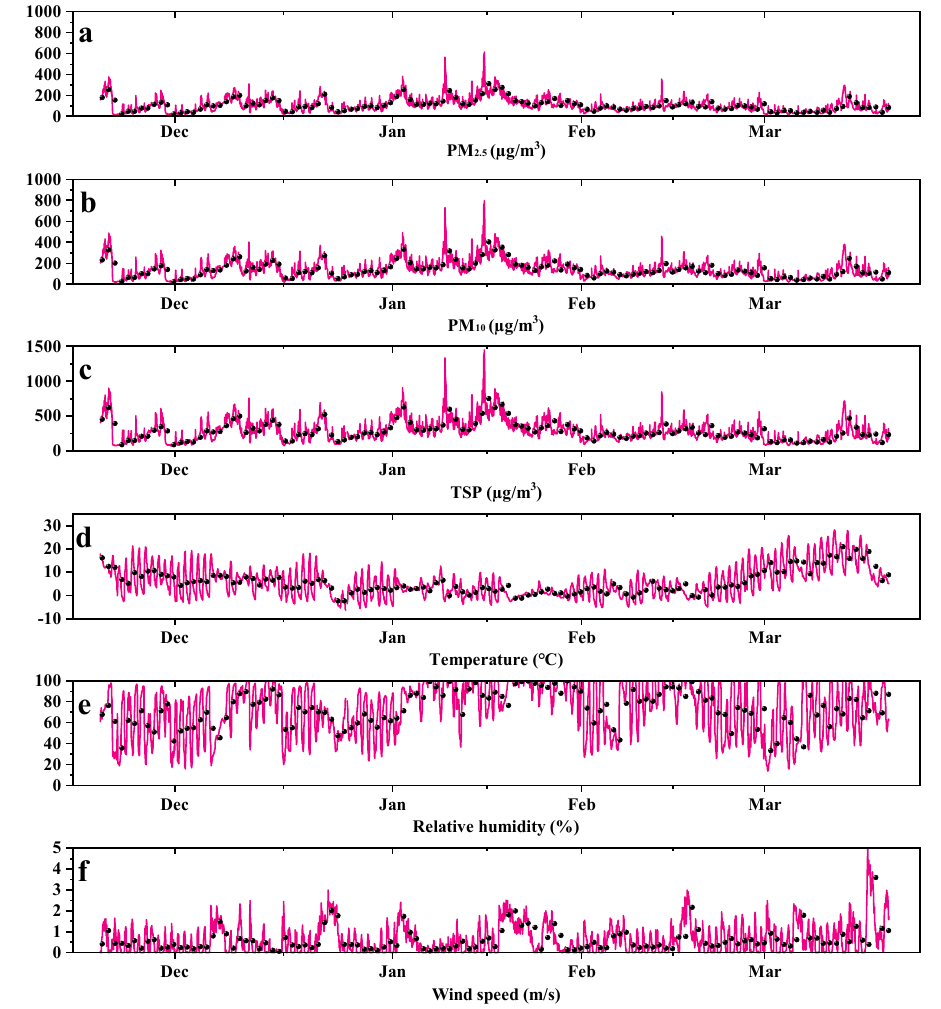
Figure 2. Time series of each variable over the whole experimental period (red line), black dots indicate the daily average of the parameters: ( a ) PM 2.5 ( µ g/m 3 ); ( b ) PM 10 ( µ g/m 3 ); ( c ) TSP ( µ g/m 3 ); ( d ) Temperature ( ◦ C); ( e ) Humidity (%); ( f ) Windspeed (m/s). Figure 4 shows the relative frequency and cumulative frequency distribution of each Table 2. Statistics of each variable of particulate ma tt er and meteorology parameters during the ex- perimental period. variable of particulate matter and meteorology during the experimental period. Skewness is a measure of the direction and degree of skewness of the data distribution, indicating the degree of asymmetry of the density curve of the probability distribution relative to the mean, which intuitively appears to be the relative length of the tail of the density function curve. The normal distribution has a skewness of zero; there is a positive skewness if the data distribution is skewed to the left, and a negative skewness if the data distribution is skewed to the right. As given in Table 2, skewness values of PM 2.5 , PM 10 , TSP, WS, T, and RH were 1.10, 1.09, 1.09, 2.34, 0.98, − 0.32, respectively, indicating that distributions of all variables are skewed to the left, except for the relative humidity, which is skewed to the right. As shown in Figure 5, concentrations of PM 2.5 were mainly concentrated in the range of 25~150 µ g/m 3 , with a relative frequency of 75%; concentrations of PM 10 were mainly concentrated in the range of 25~200 µ g/m 3 , with a relative frequency of 79%; concentrations of TSP were mainly concentrated in the range of 100~375 µ g/m 3 , with a relative frequency of 79%. The distribution of T ( ◦ C) was mainly concentrated between − 2.5~10 ◦ C, with a relative frequency of 86%; RH (%) is mainly concentrated between 80%~100%, with a relative frequency of 54%, indicating that the relative humidity is high during